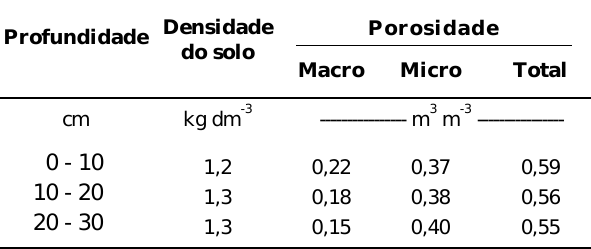
Quadro 2. Valores de densidade do solo, macro,